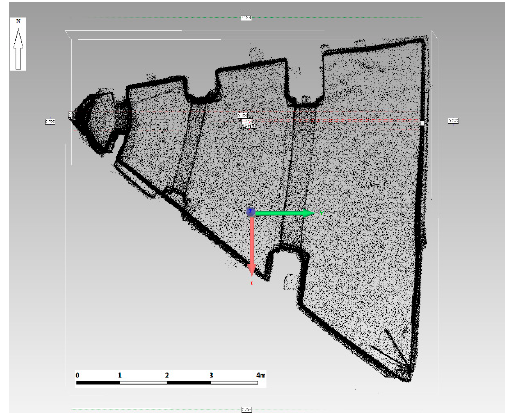
Figure 15. The ground-plan of the synagogue from the point cloud (ZEB-REVO). Table 3. Comparison of the instruments used for the synagogue in the Amezrou.